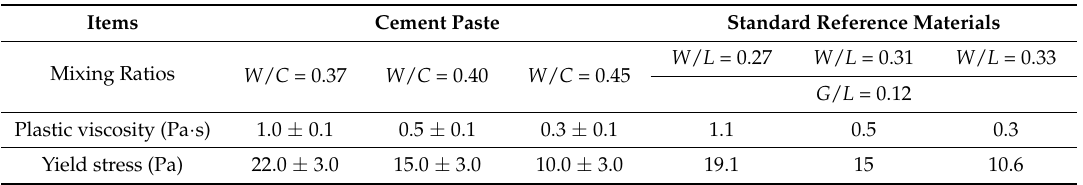
Figure 9. Test results of rheology for derived SRM mixing ratios. Table 4. Comparison of flow characteristics between cement pastes and suggested standard reference materials.